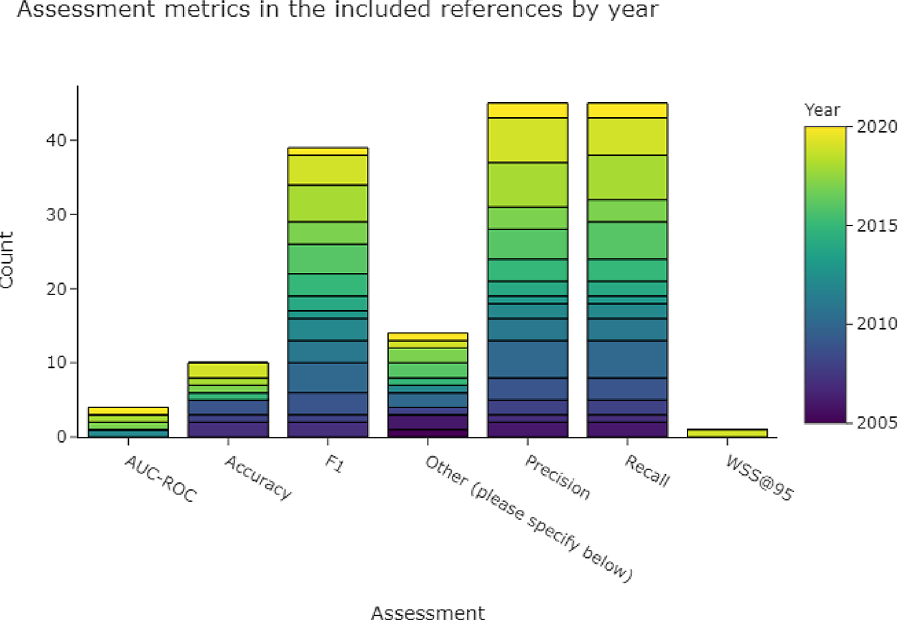
Figure 4. The most common assessment metrics used in the included publications in order to evaluate the performance of a data extraction system. More than one metric per publication is possible, which means that the totalnumberofincludedpublications(n=53)islowerthanthesumofcountsofthebarswithinthisfigure.AUC-ROC, area under the curve - receiver operator characteristics; F1, harmonic mean of precision and